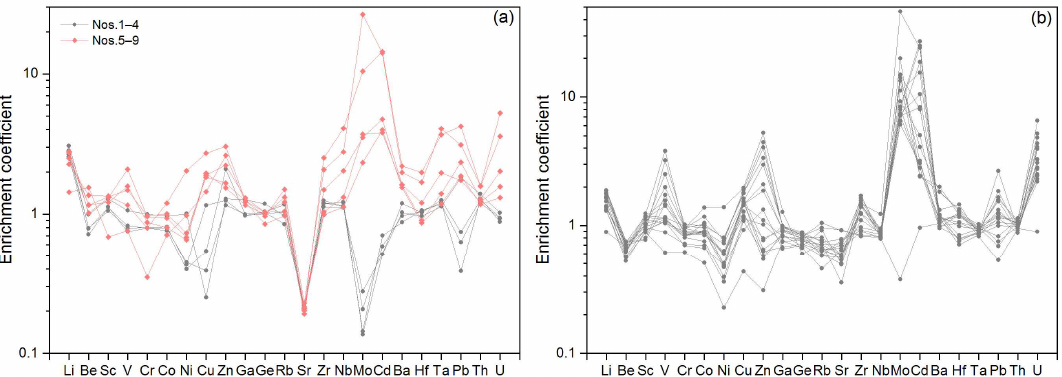
Figure 3. UCC-normalized trace element distributions for the Wufeng-Longmaxi shale ( a ) and the Niutitang shale ( b ). The enrichment coefficient can be expressed as X sample /X UCC , where X represents the weight concentrations of elements X.